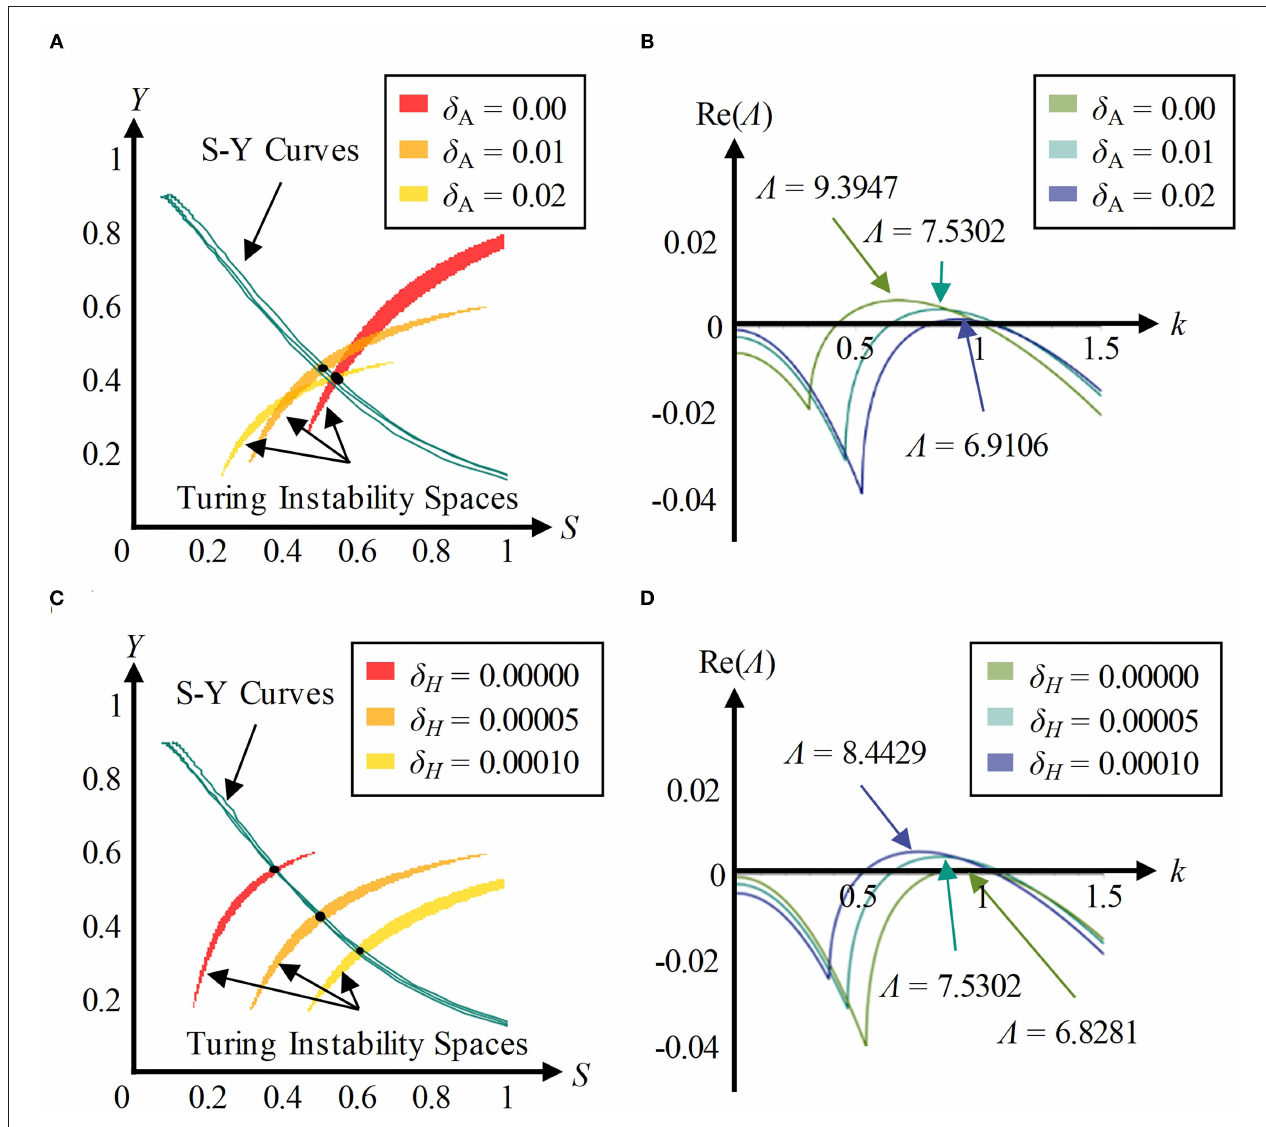
FIGURE 7 | Exogenous substances regulate dendritic spine density through Turing wavelength. (A) The S-Y curve and Turing instability space in three conditions of parameter δ A ( δ H = 0.00005, ε = 1). The yellow, orange, and red regions represent Turing instability spaces in the conditions of δ A = 0, 0.01, and 0.02, respectively. The cyan lines represent S-Y curves, and the black points represent the intersections. An exogenous activator affects the size and location of the Turing instability space, rather than the S-Y curves (artificial errors in choosing intersections result in non-coincidence). (B) The dispersion relationship curves in the conditions of δ A = 0, 0.01, and 0.02 ( δ H = 0.00005, ε = 1). Adding an exogenous activator decreases the Turing wavelength. (C) The S-Y curve and Turing instability space in three conditions of parameter δ H ( δ A = 0.01, ε = 1). The yellow, orange, and red regions represent Turing instability spaces in the conditions of δ H = 0, 0.00005, and 0.0001, respectively. The cyan lines represent S-Y curves, and the black points represent the intersections. An exogenous inhibitor affects the size and location of the Turing instability space, rather than the S-Y curves (artificial errors in choosing intersections result in non-coincidence). (D) The dispersion relationship curves in the conditions of δ H = 0, 0.00005, and 0.0001 ( δ A = 0.01, ε = 1). Adding an exogenous inhibitor increases the Turing